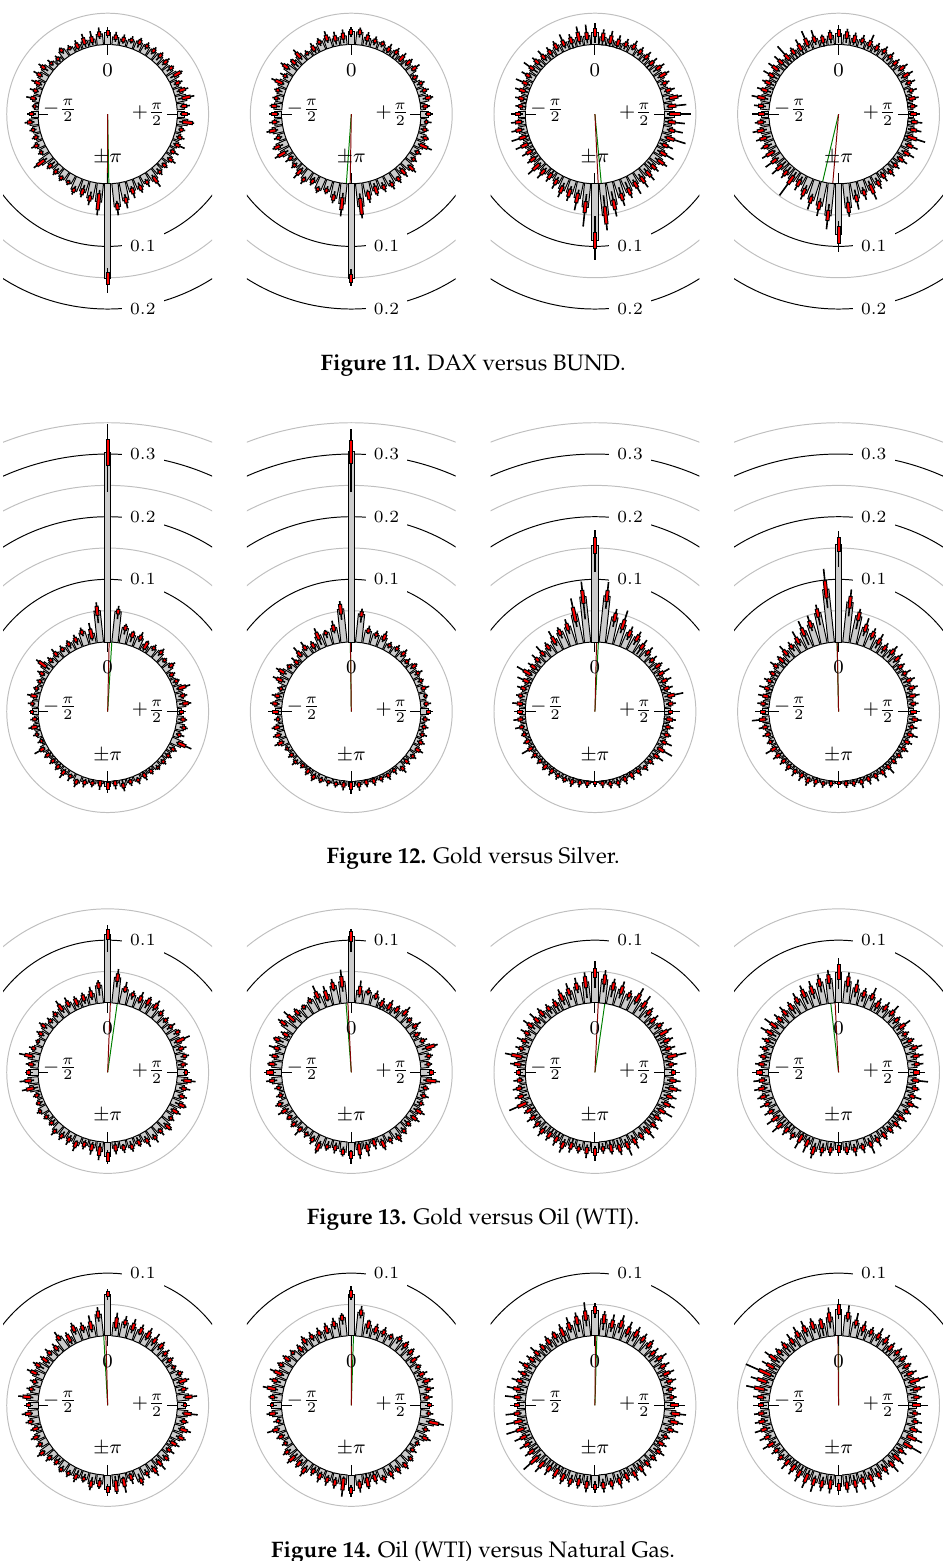
Figure 14. Oil (WTI) versus Natural